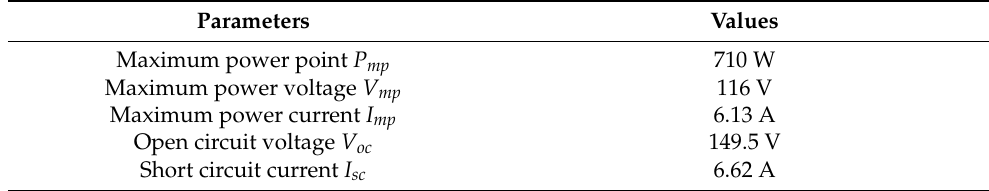
Table 5. Electrical specifications of the PV array @ S = 800 W/m 2 and T = 47 ◦ C